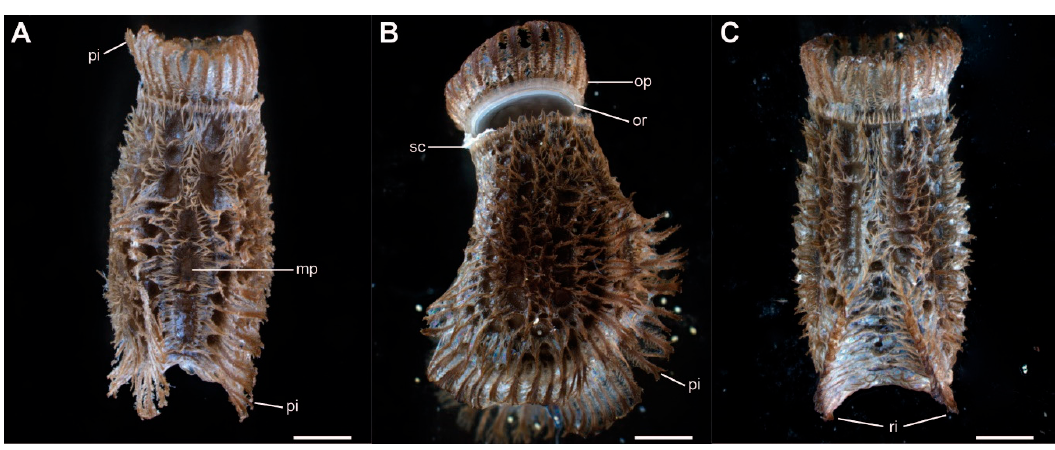
Figure 2. Morphology of the eggs of Phyllium philippinicum . ( A ) Dorsal view. ( B ) Lateral view. ( C ) Ventral view. mp , micropyle; op , operculum; or , opercular rim; pi , pinnae; ri , ribs; sc , serosal cuticle. Scale bars: 1 mm.